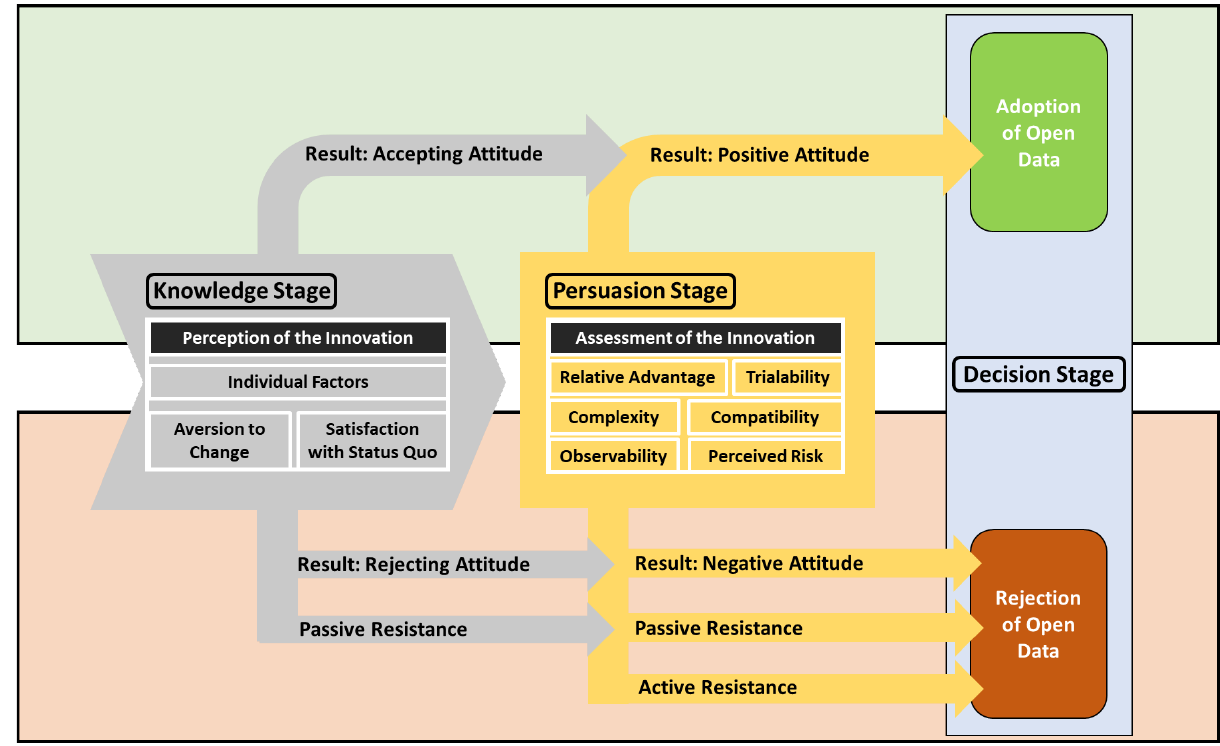
Figure 1: Innovation-decision process with regard to Open